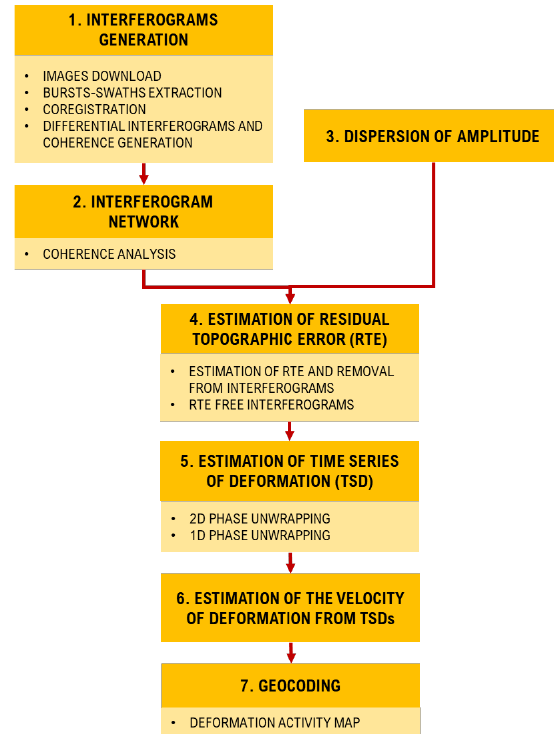
Figure 4. Flowchart of the PSIG chain used in this work As a first operation, a DTM (Digital Terrain Model) was obtained from Earth Explorer (https://earthexplorer.usgs.gov/) platform, which provides to know the morphology of the area of interest to be analysed and acts as a support for the visualisation of the SAR